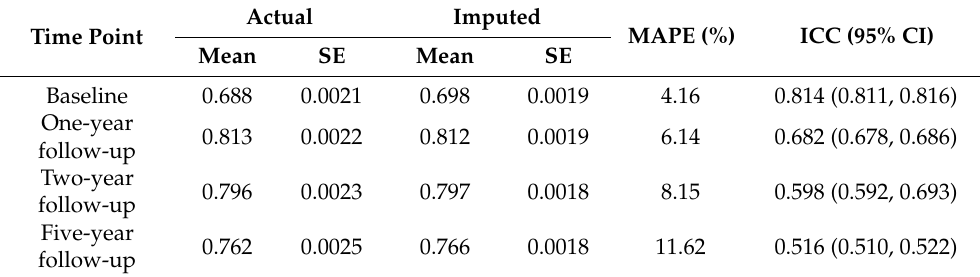
Table 4. Comparison of actual and imputed SF-6D indices at baseline and